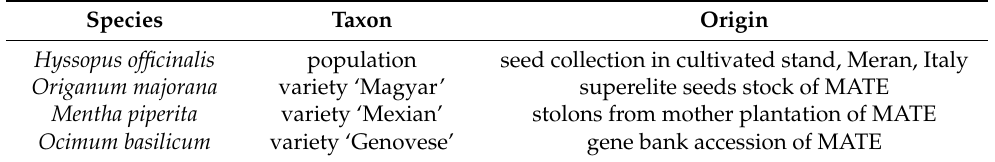
Table 1. Plant material and its origin.